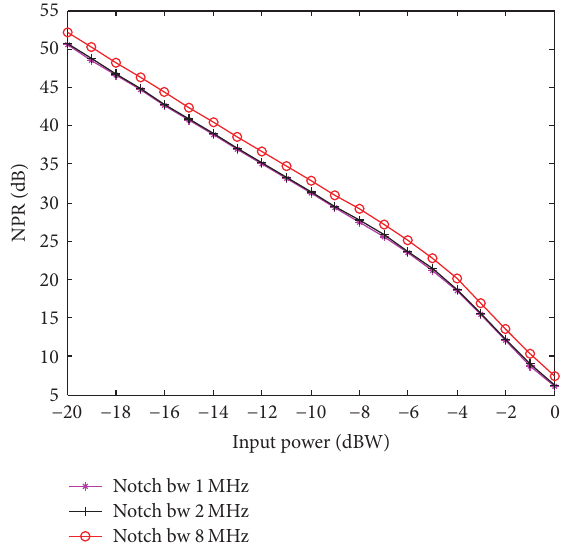
Figure 11: Plot of NPR versus the input power level.